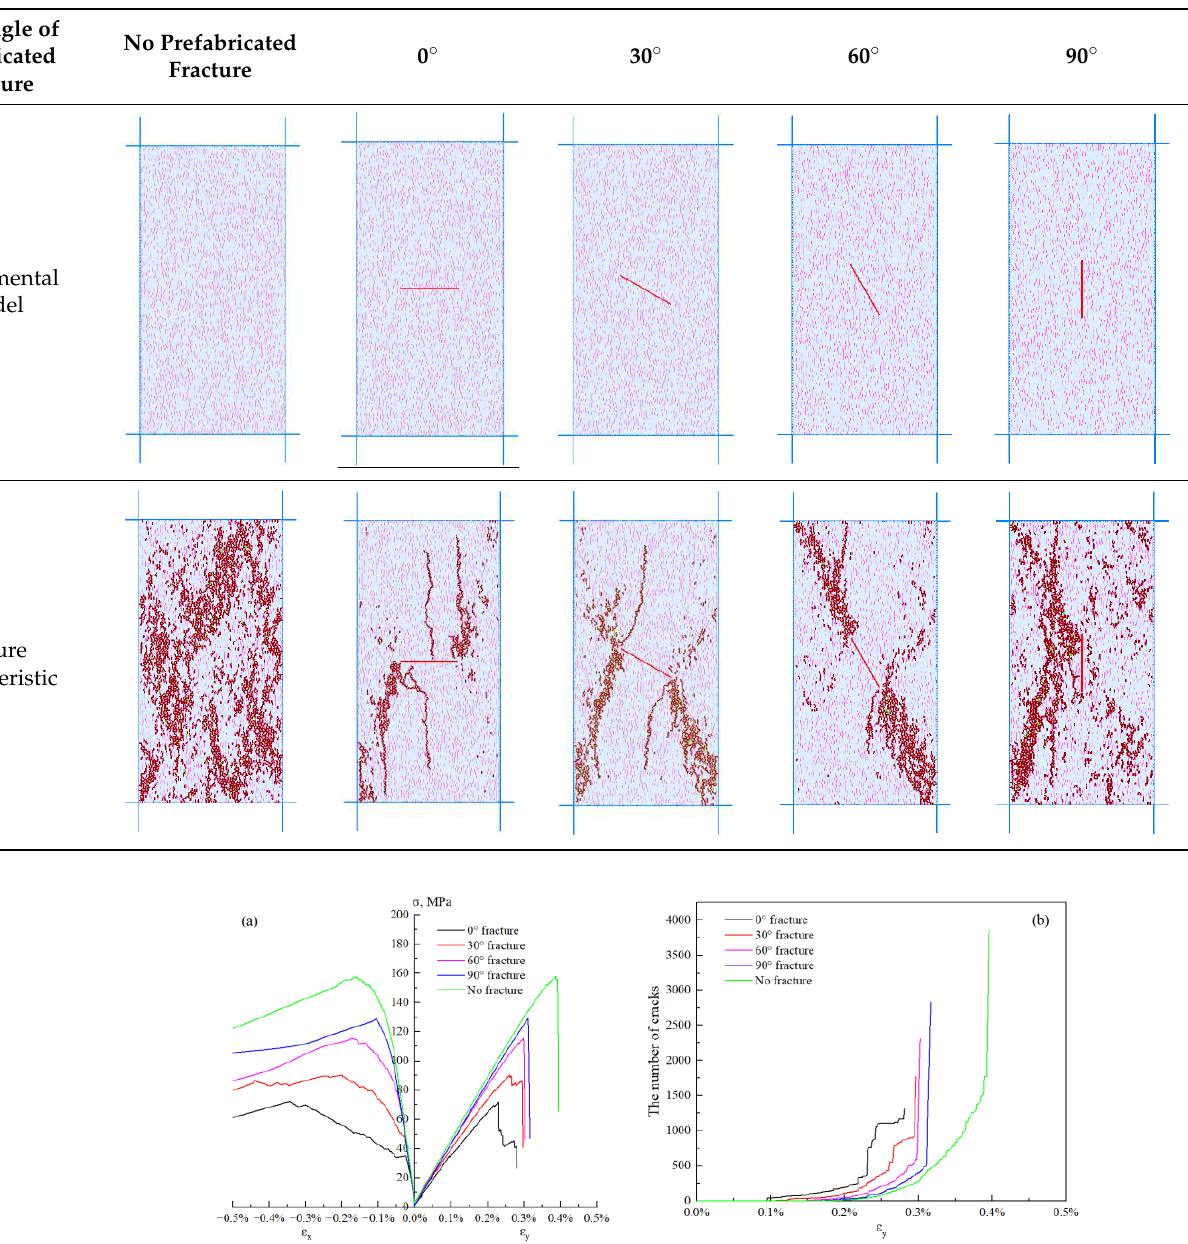
Figure 3. ( a ) The complete stress-strain curves and ( b ) the number of cracks of prefabricated fracture samples with different angles under triaxial compression.